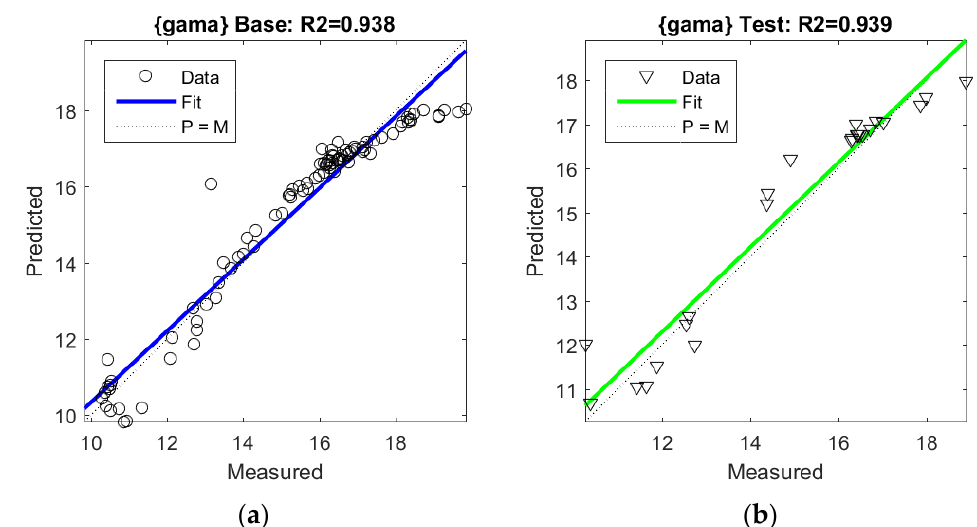
Figure 13. Regression of the F6 model of soil unit weight ( LOI T , w ): ( a ) base data and ( b ) test data.